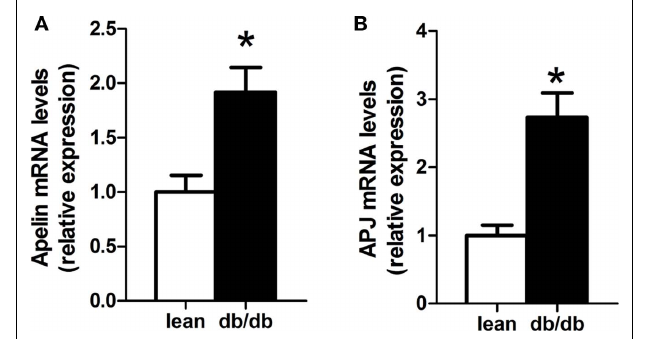
FIGURE 4 | Increased apelin andAPJ mRNA expression in the adipose tissue of db / db mice. (A) Apelin and (B) APJ mRNA expression measured in adipose tissue. Mean ± SEM, n = 6/group, * P < 0.05 determined by a two-tailed Student’s t